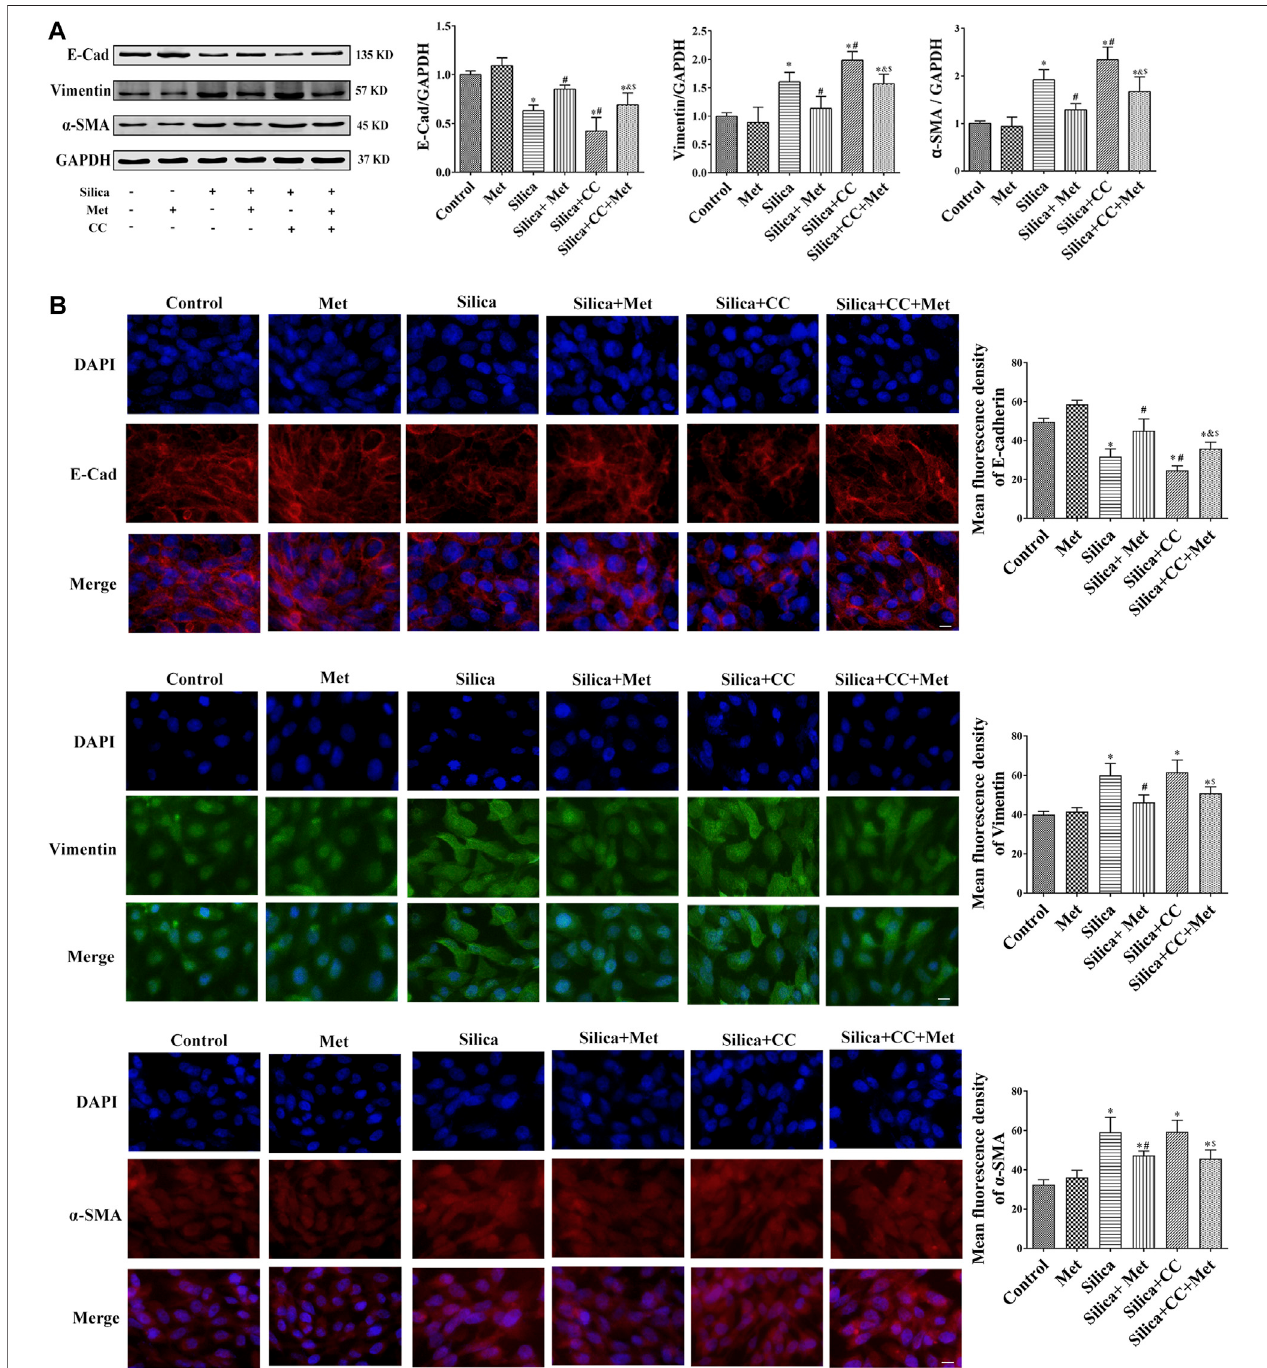
FIGURE 7 | Metformin regulates the expression of EMT-related proteins induced by silica particles. (A) The expression level of the expressions of EMT-associated proteins expression level in HBEC cells were detected by Western blot and the E-Cad, Vimentin and α -SMA were detected by (B) Immuno fl uorescence. Scale bar, 10 μ m. All the data are presented as mean ± SD ( n (cid:2) 3 for each experimental group). * p < 0.05, compared to the negative control group; # p < 0.05, compared to silica group; & p < 0.05, compared toSilica +Met group; $ p < 0.05, compared toSilica +CC group. EMT, epithelial-mesenchymal transition; E-cad, E-Cadherin; α -SMA, α -Smooth muscle actin; Met, metformin; CC, Compound C.